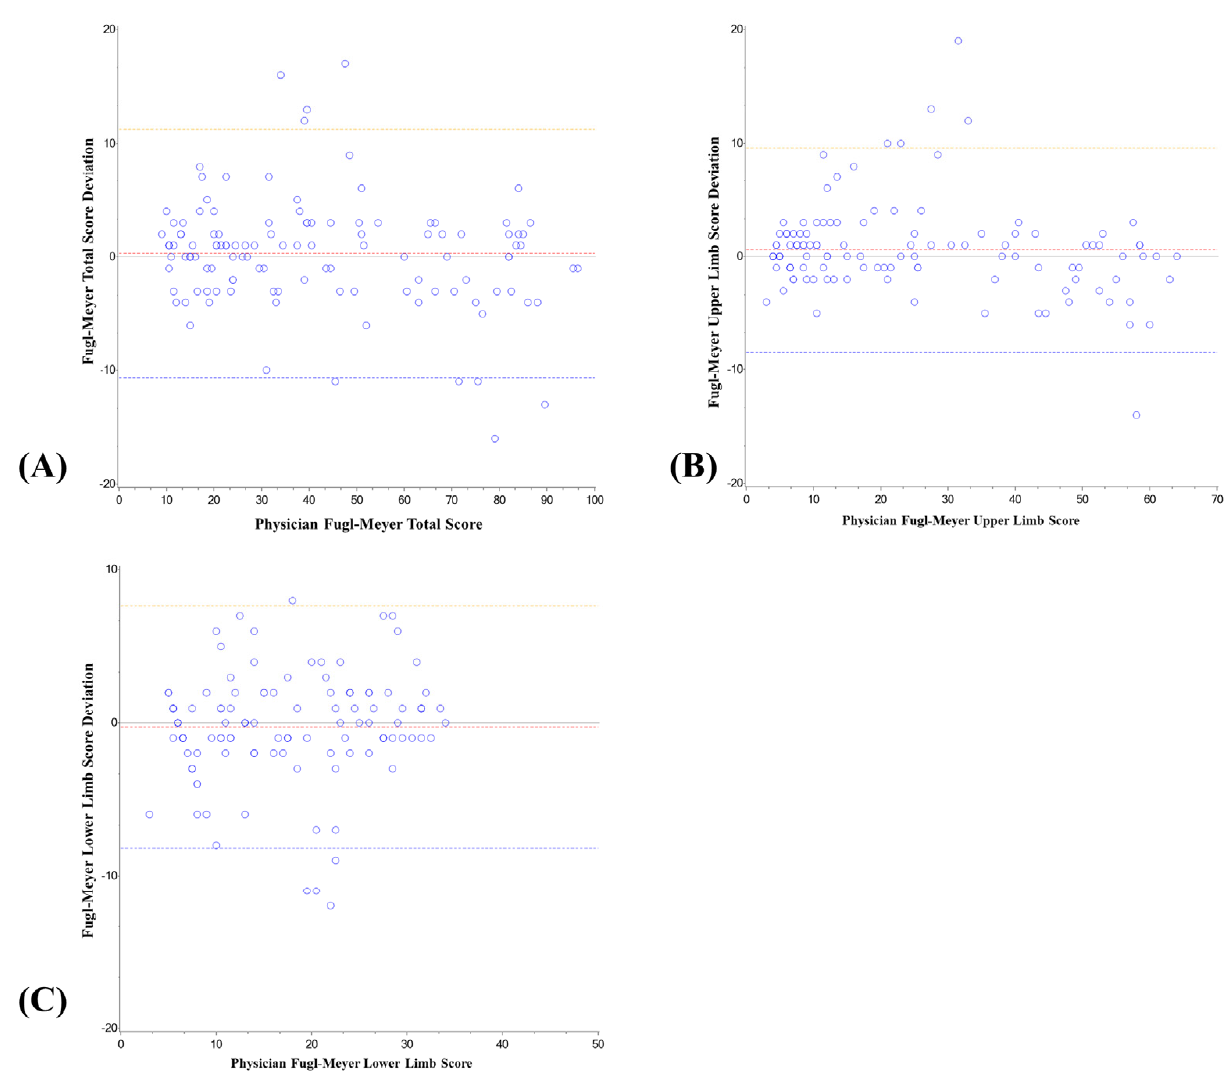
Table 4. The score deviation and relative deviation (%) of the intelligent rehabilitation assessment system and the physician’s FMA score.